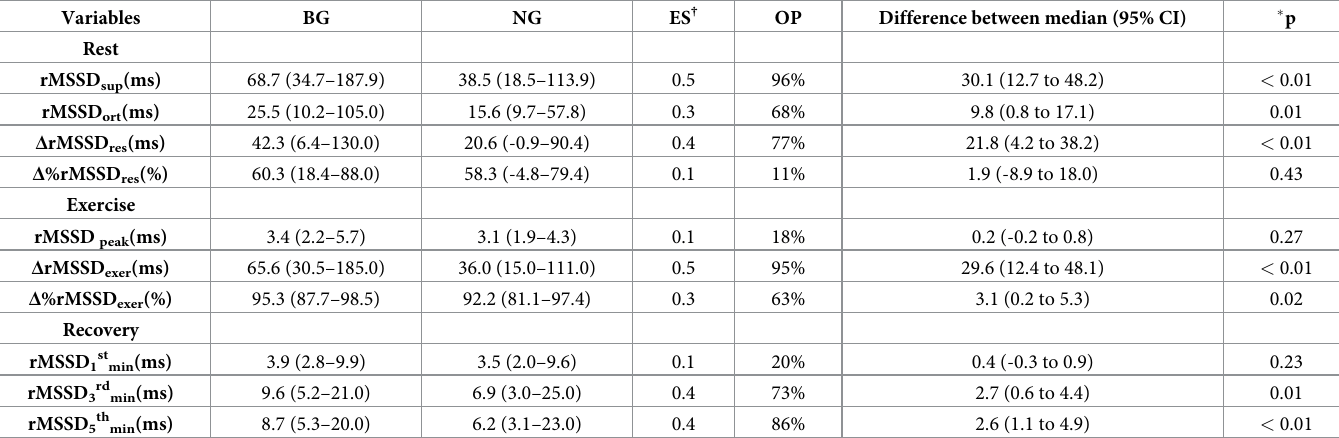
Table 3. Median (25 th – 75 th ) comparative values of the parasympathetic cardiac activity before, during, and after a submaximal exercise test.